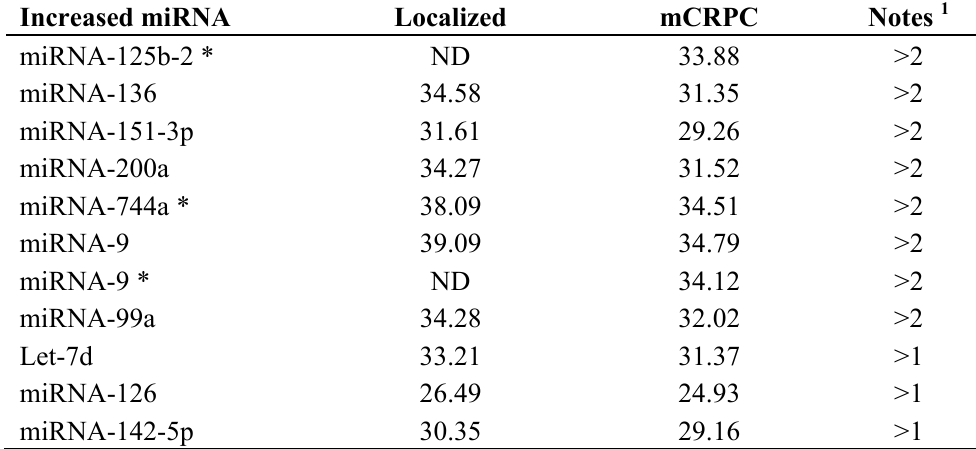
Table 1. Cq values for miRNAs that show similar trends in expression differences in plasma from patients with localized PCa versus mCRPC and in non-metastatic versus metastatic tumor